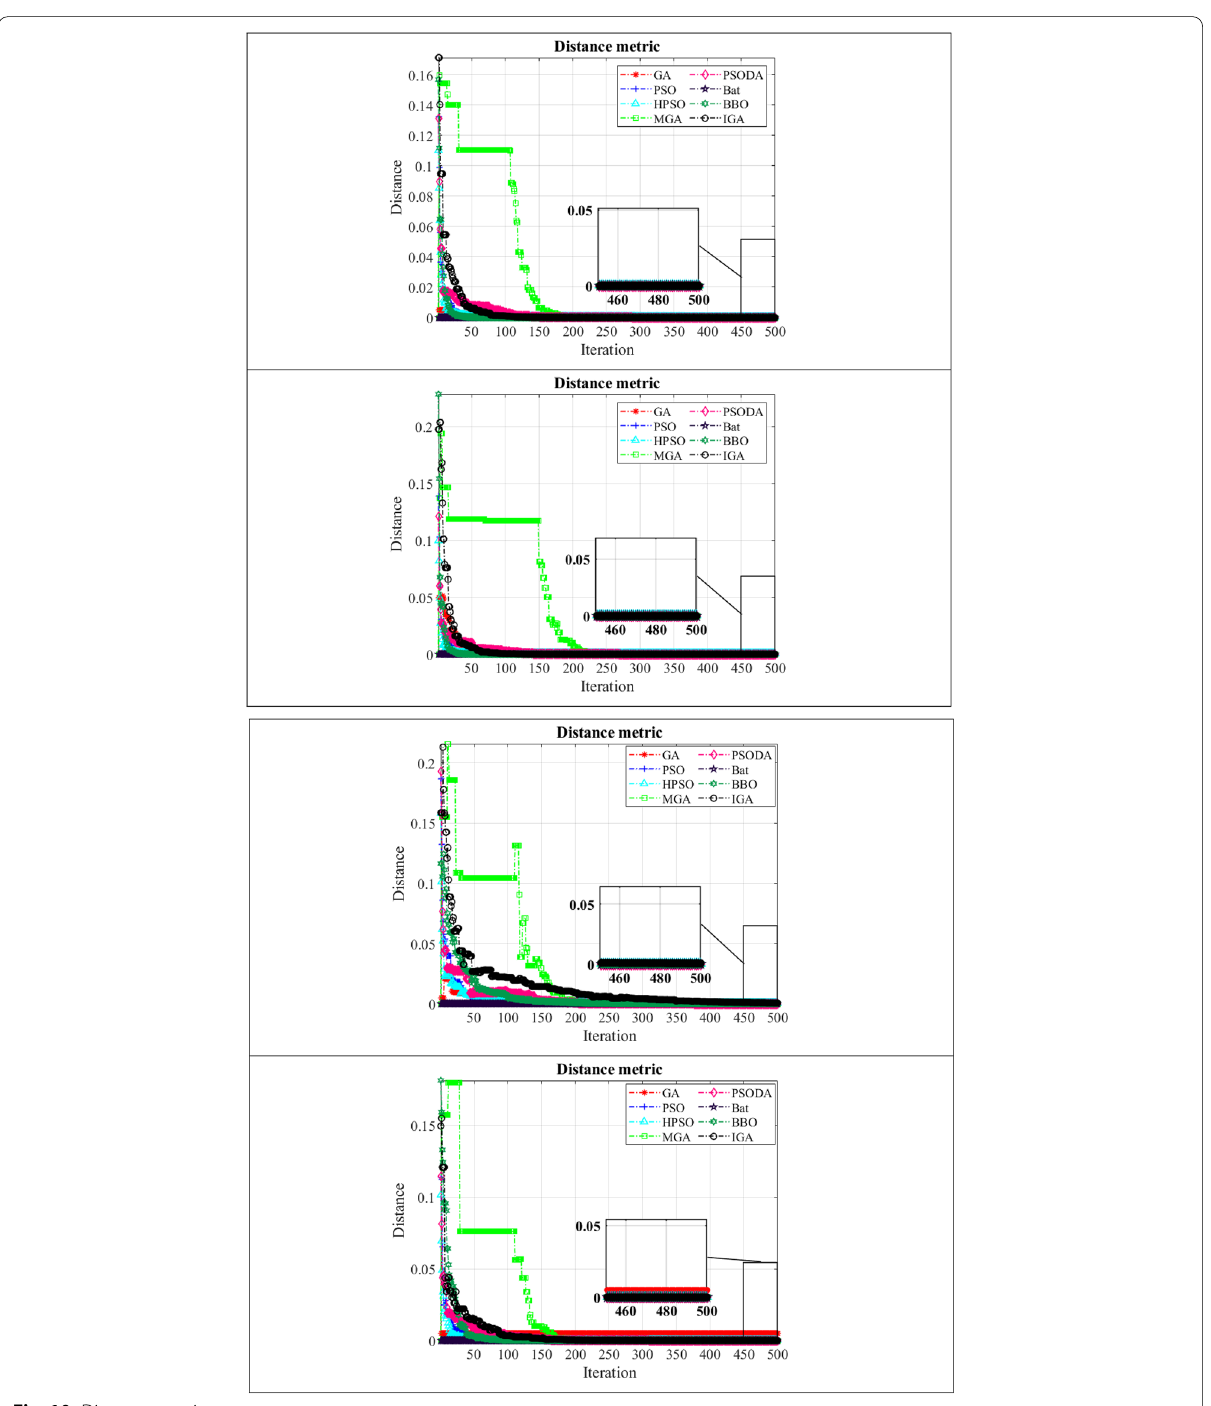
Fig. 10 Distance